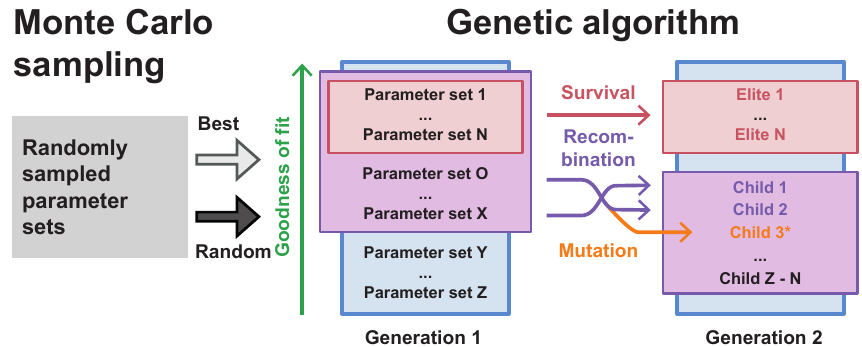
Figure 1. Schematic representation of the MCGA optimization method consisting of a Monte Carlo sampling, which feeds into a genetic algorithm. Populations of model input parameter sets (blue boxes) are iteratively improved over several generations through survival of elites (red boxes) and recombination and mutation of parents to create children (purple boxes) until a sufficient correlation to the experimental data (goodness of fit) is